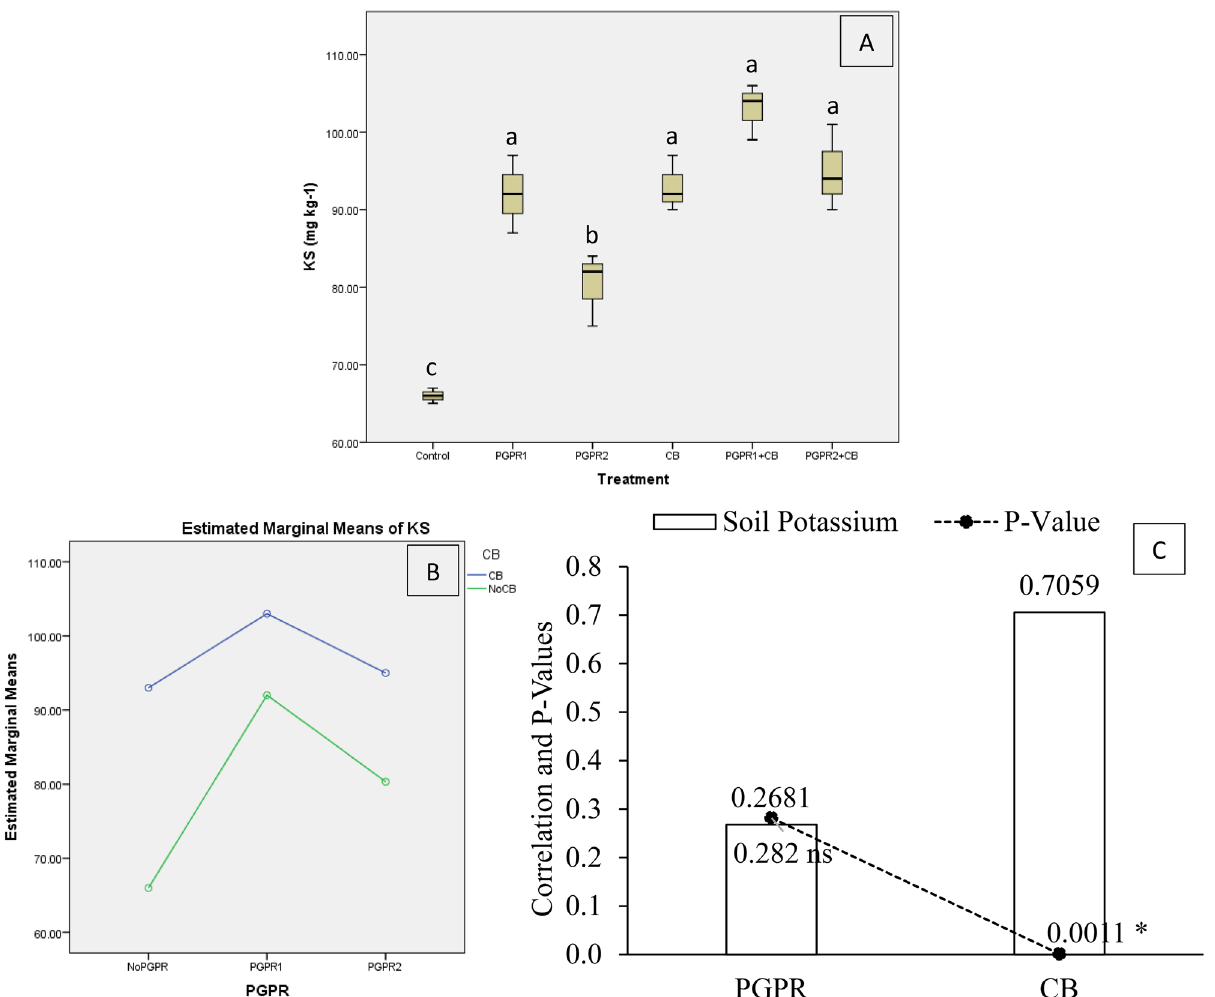
Figure 6. Effect of treatments on soil potassium (KS). Values are the average of three replicates ( A ). Different letters showed significant differences (Tukey ‘s test; p ≤ 0.05). Interaction graph of PGPR and CB for soil KS ( B ). Correlation graph of PGPR and CB for soil KS ( C